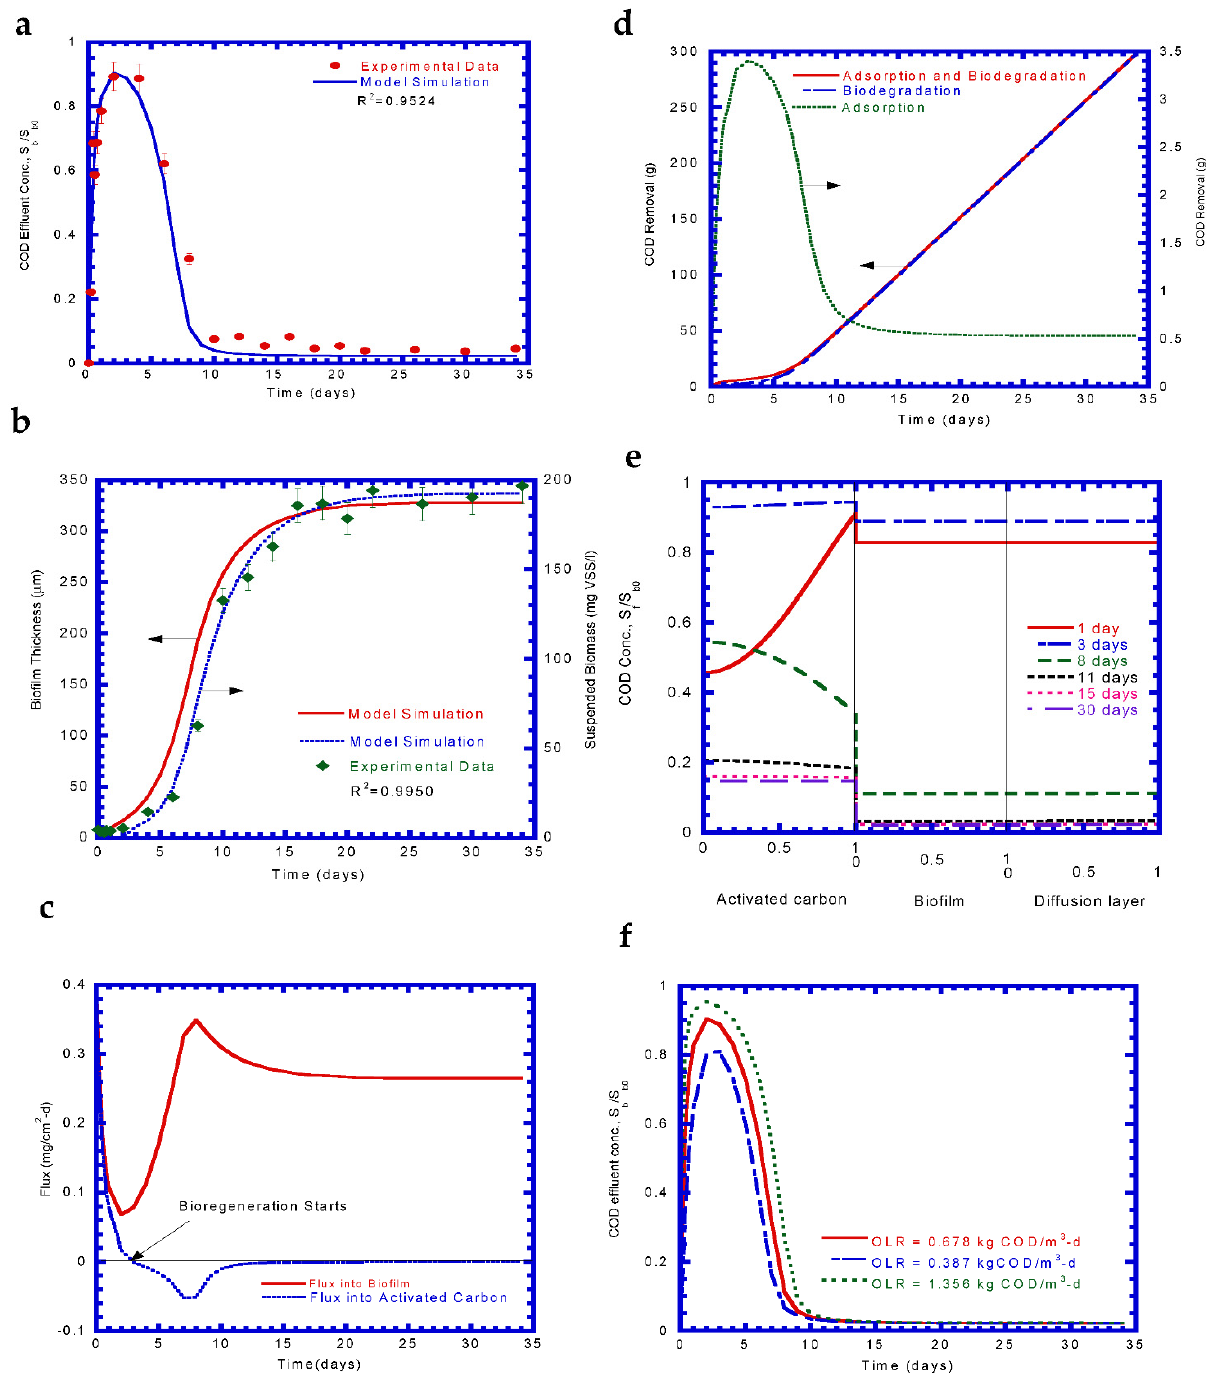
Figure 7. Experimental results and model simulation: ( a ) COD effluent, ( b ) biomass growth, ( c ) flux into biofilm and activated carbon, ( d ) COD removal, ( e ) COD profiles, and ( f ) COD effluent at various organic loading rates (OLR).